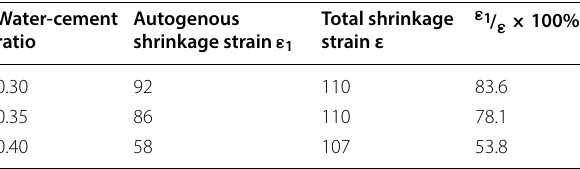
Table 11 Autogenous shrinkage strain and total shrinkage strain of cement mortar with different